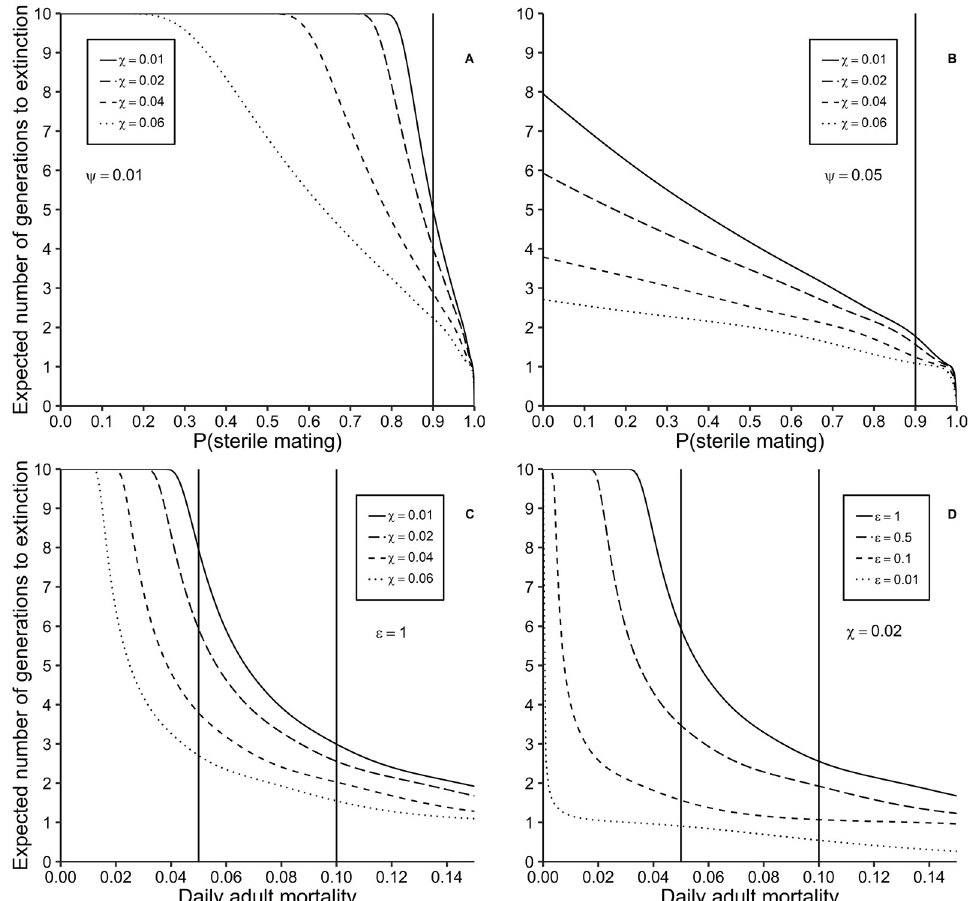
Fig 2. Expected number of generations to extinction as a function of various input parameters. Expected number of generations to extinction as a function of: A. The probability (1- � ) of sterile mating for different levels of daily pupal mortality ( χ ), at daily adult mortality ψ = 1%. B. The probability of sterile mating for different levels of daily pupal mortality, at daily adult mortality = 5%. C. Daily adult mortality for different levels of daily pupal mortality, and with no sterile mating: � = 1. D. Daily adult mortality for different levels of probability of insemination, at daily pupal mortality = 2%.